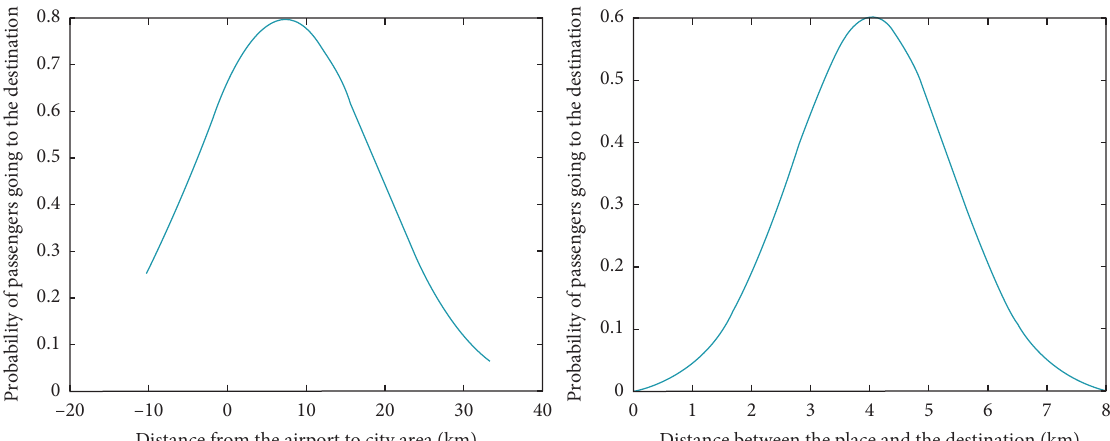
Figure 6: Normal distribution of the